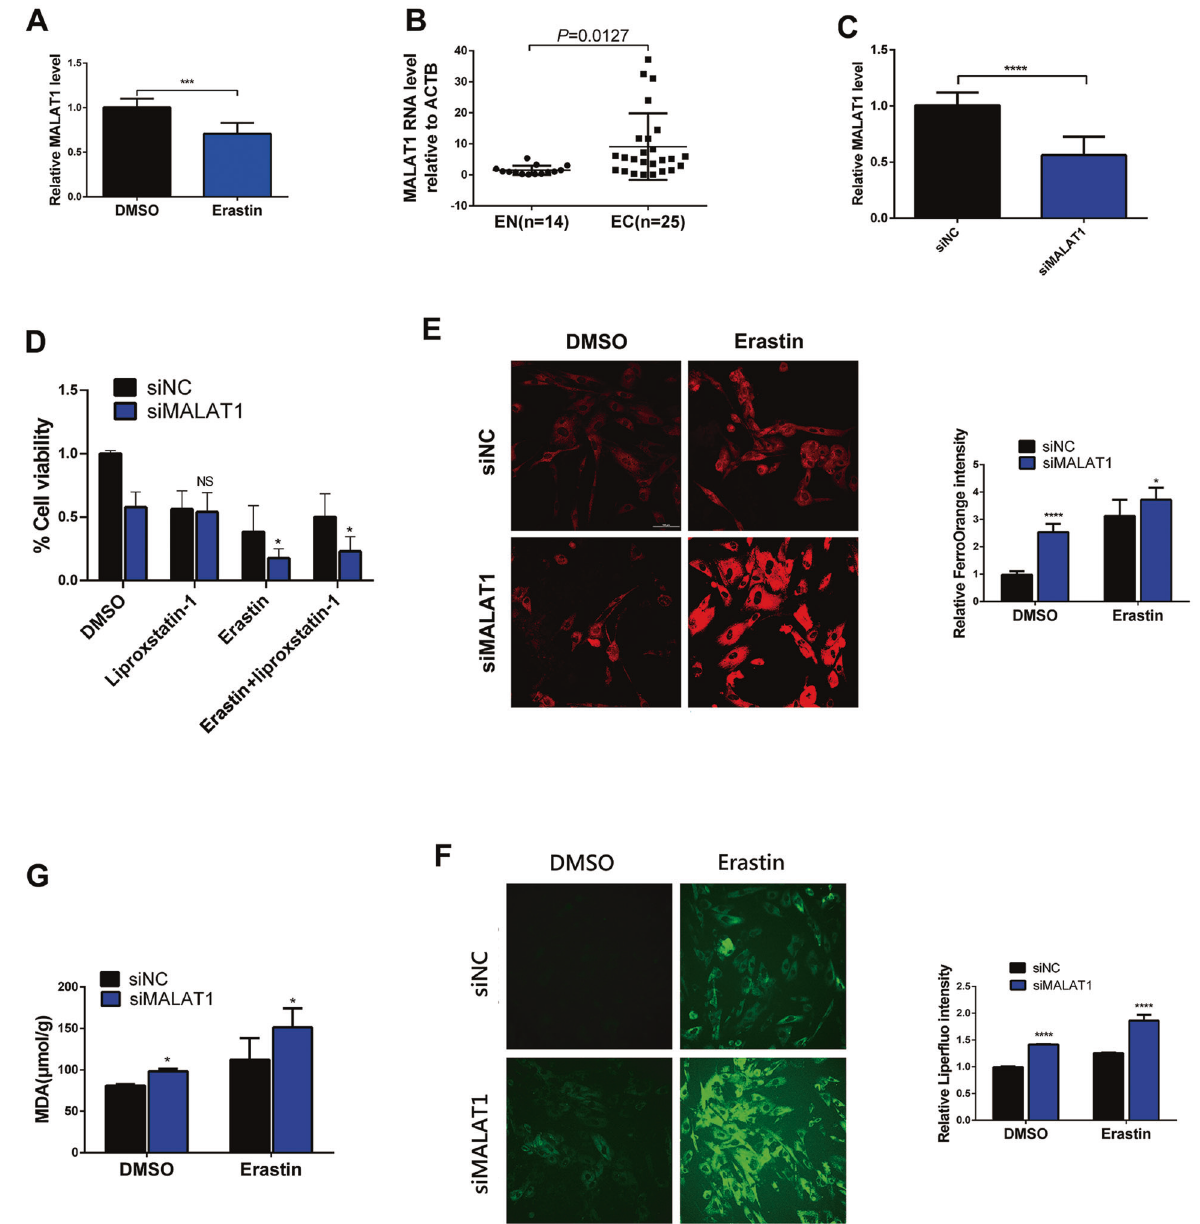
Fig. 3 Knockdown of MALAT1 facilitates erastin-induced ferroptosis in EESCs. A qRT-PCR analysis was conducted to test the expression level of MALAT1 in EESCs after treatment with erastin (10 µM) or DMSO for 24 h. B The mRNA levels of MALAT1 in 25 EC tissues and 14 EN tissues were detected by qRT-PCR. C qRT-PCR analysis was performed to detect the ef fi ciency of siRNA-mediated knockdown of MALAT1 in EESCs that were transiently transfected with siMALAT1 (50 nM) or siNC (50 nM) for 24 h. D Cell growth was detected by CCK-8 assay upon erastin (10 μ M) and/or liproxstatin-1 (1 μ M) treatment in MALAT1 knockdown cells. E , F Cells were treated with 1 µM FerroOrange and 5 µM Liper fl uo to detect intracellular Fe 2 + and lipid peroxidation after MALAT1 knockdown upon erastin (10 μ M) treatment. E Intracellular Fe 2 + visualized by FerroOrange (magni fi cation, ×200). F Ferroptosis marker visualized by Liper fl uo (magni fi cation, ×200). G MDA levels were assayed in MALAT1 knockdown cells under erastin (10 μ M) treatment. All data are shown as the mean ± SD of three independent experiments (NS is nonsigni fi cant, * P < 0.05, *** P < 0.001, **** P < 0.0001). Statistical signi fi cance was calculated using Student ’ s t test. EC ectopic endometrial, EN normal endometrial, EESC ectopic endometrial stromal cell, MALAT1 metastasis-associated lung adenocarcinoma transcript 1, siNC negative control siRNA, siMALAT1 siRNA targeting